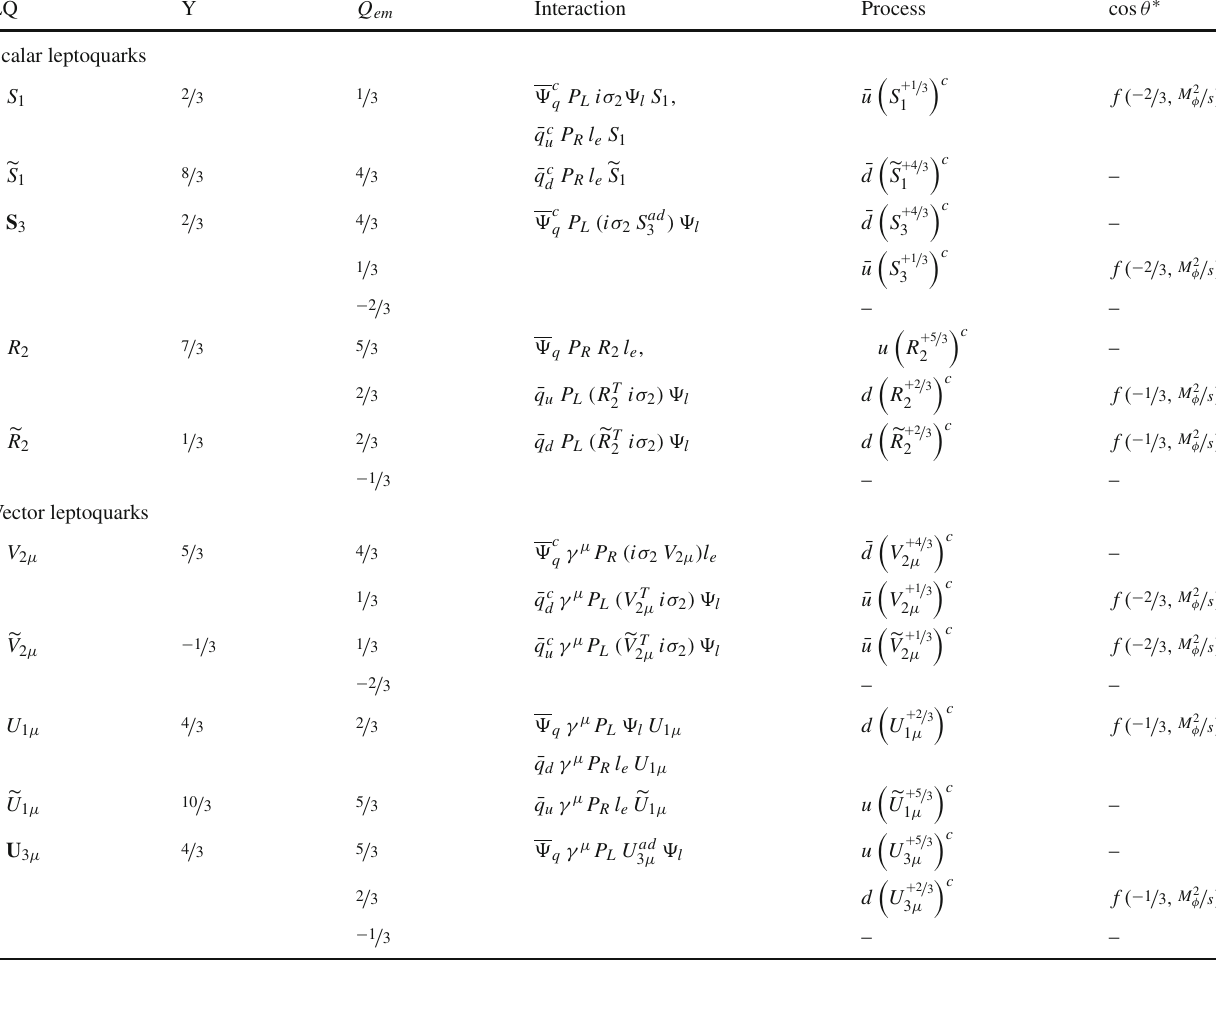
Table 1 The values of cos θ ∗ for production of different leptoquarks at e − γ collider LQ Y Q em Interaction Process cos θ ∗ Scalar